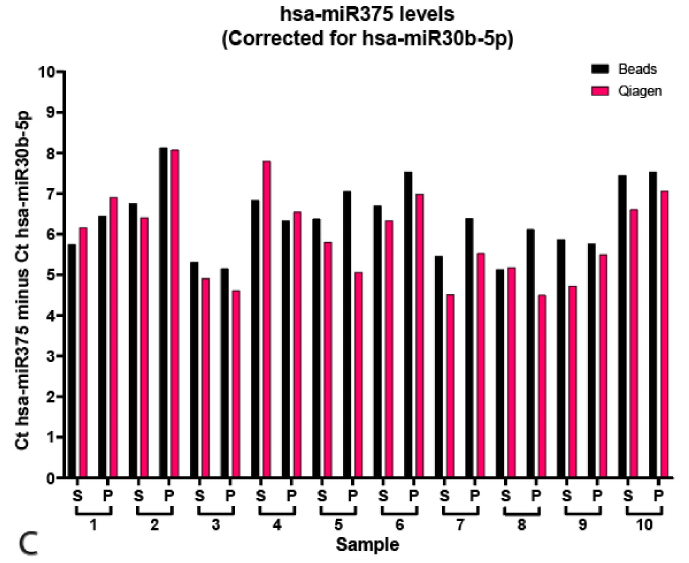
Figure 3. Targeted miR profiling. ( A ) Qiagen isolated levels of hsa-miR371a-3p levels plotted as 40— (Ct371—(Ct30b—Ct30b average) for plasma and serum (black) or serum only (pink). ( B ) Bead-capture isolated levels of hsa-371a-3p levels plotted as 40—(Ct371—(Ct30b—Ct30b average) for plasma and serum (black) or serum only (pink). ( C ) Levels of hsa-miR375 plotted as Ct hsa-miR375—hsa-miR30b for bead-capture (black) or Qiagen kit (pink) isolated samples. ∆ Ct Qiagen vs. Beads 0.65 ± 0.50, p = 0.16), ∆ Ct serum vs. plasma Qiagen 0.83 ± 0.40, p = 0.64, ∆ Ct serum vs. plasma Beads 0.63 ± 0.43, p = 0.22. Table 3. Serum marker TGCT patients. Serum marker levels of classical GCT serum markers AFP, b-HCG and LDH. Cells marked with red indicate clinically elevated (above threshold) serum levels of these markers. Pre- Orchiectomy Markers Sample-nr. AFP ug/L b-HCG